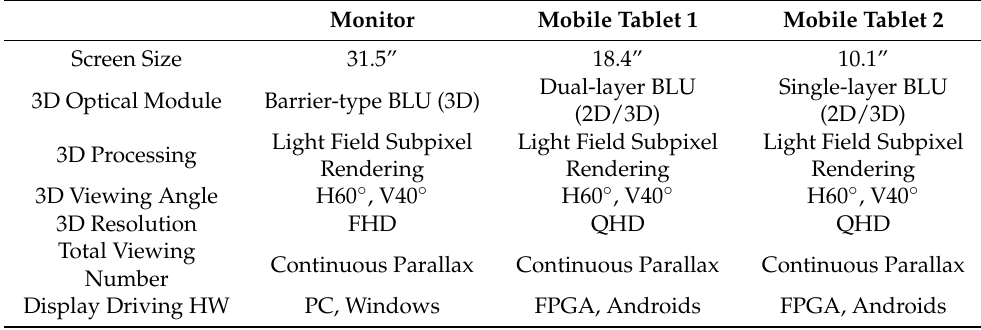
Table 1. Complete specifications of the proposed autostereoscopic 3D display system prototype based on eye tracking for medical 3D image applications.